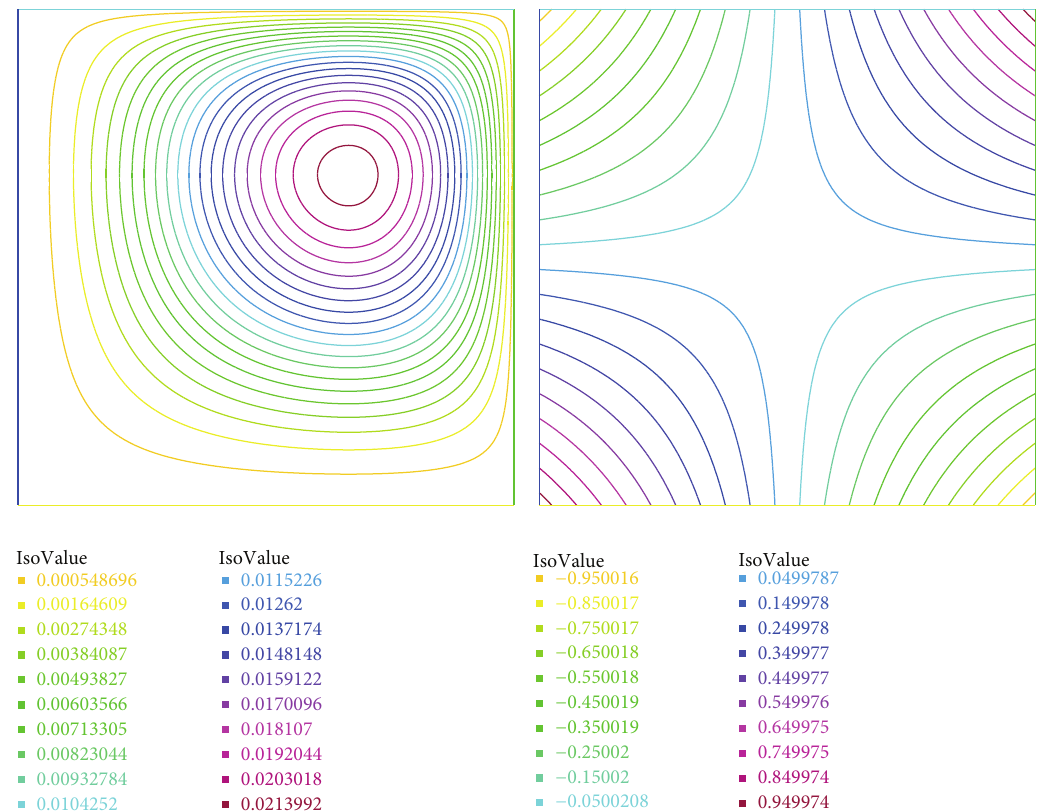
Figure 3: Streamline of flow and pressure contour by Stokes